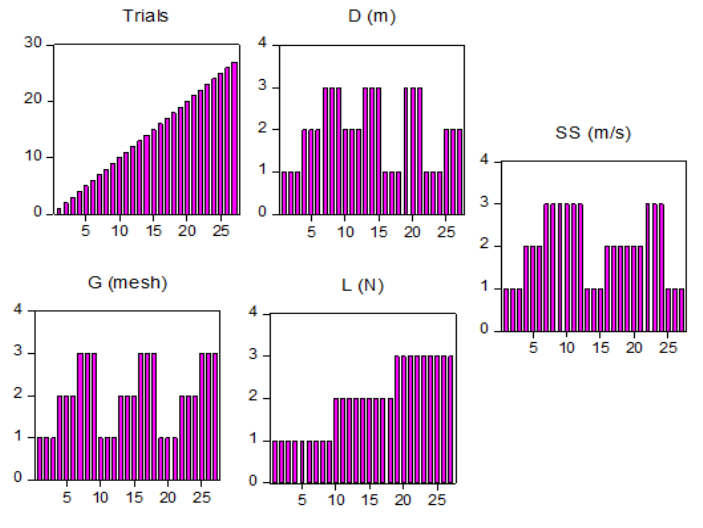
Figure 3. Taguchi L 27 (3 4 ) OA. Table 3. Signal noise ratio of against SiC particle based on Taguchi L (cid:2870)(cid:2875) (3 4 ) OA.